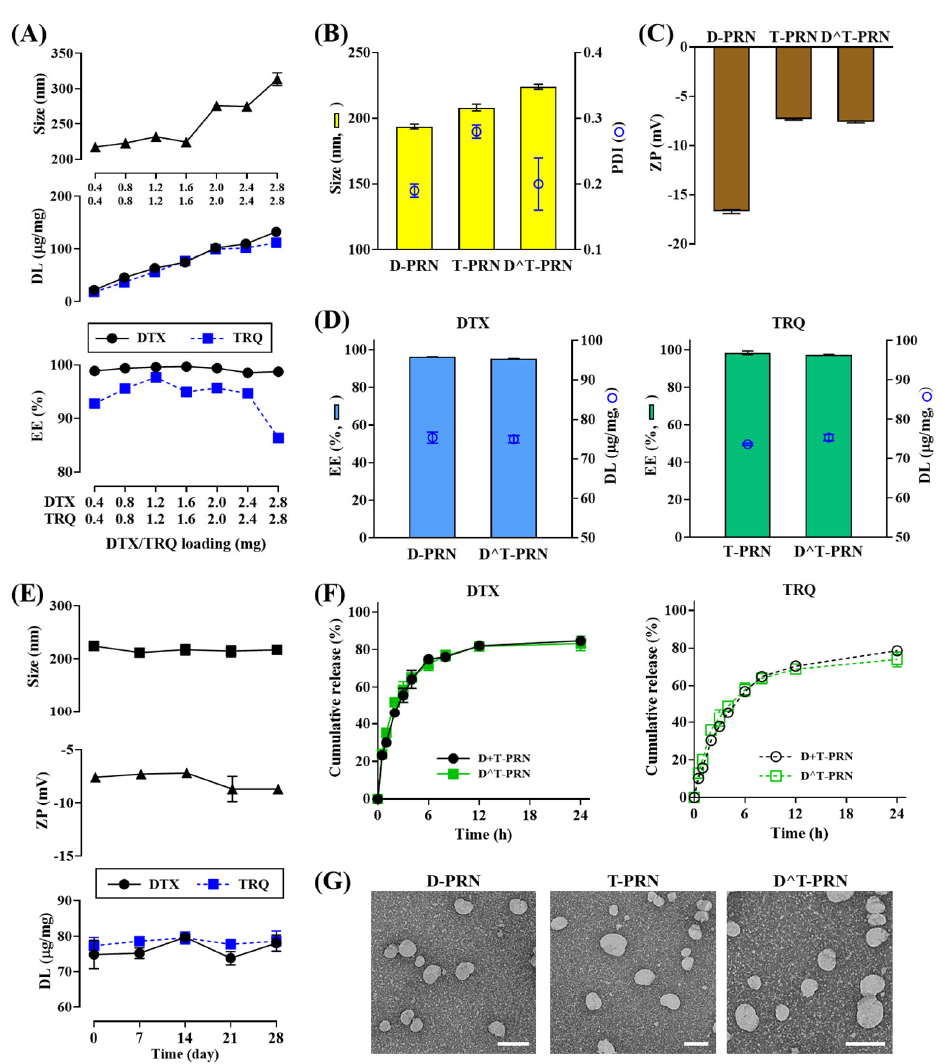
Figure 2. Characteristics of docetaxel (DTX) ‐ and/or tariquidar (TRQ) ‐ loaded PEGylated (5 mol%) and RIPL peptide ‐ conjugated nanostructured lipid carrier (PRN) samples. ( A ) Determination of the particle size, drug ‐ loading (DL) capacity, and encapsulation efficiency (EE) of DTX ‐ and TRQ ‐ loaded PRN (D^T ‐ PRN). The ratio of DTX and TRQ was fixed as 1:1 ( w / w ), and the amounts of DTX and TRQ ranged from 0.4 to 2.8 mg. ( B ) Particle sizes of the drug ‐ loaded PRN samples. ( C ) Zeta potential (ZP) of drug ‐ loaded PRN samples. ( D ) EE and DL capacity of drug ‐ loaded PRN samples. ( E ) Physical stability of D^T ‐ PRN stored at 4 °C for 4 weeks. ( F ) In vitro release profiles of DTX and TRQ from the physically mixed dual ‐ carrier system of DTX ‐ loaded PRN (D ‐ PRN) and TRQ ‐ loaded PRN (T ‐ PRN) (D+T ‐ PRN) or D^T ‐ PRN. ( G ) Transmission electron microscopy images. Scale bar = 200 nm. Data represent the mean ± standard deviation (SD) ( n = 3).